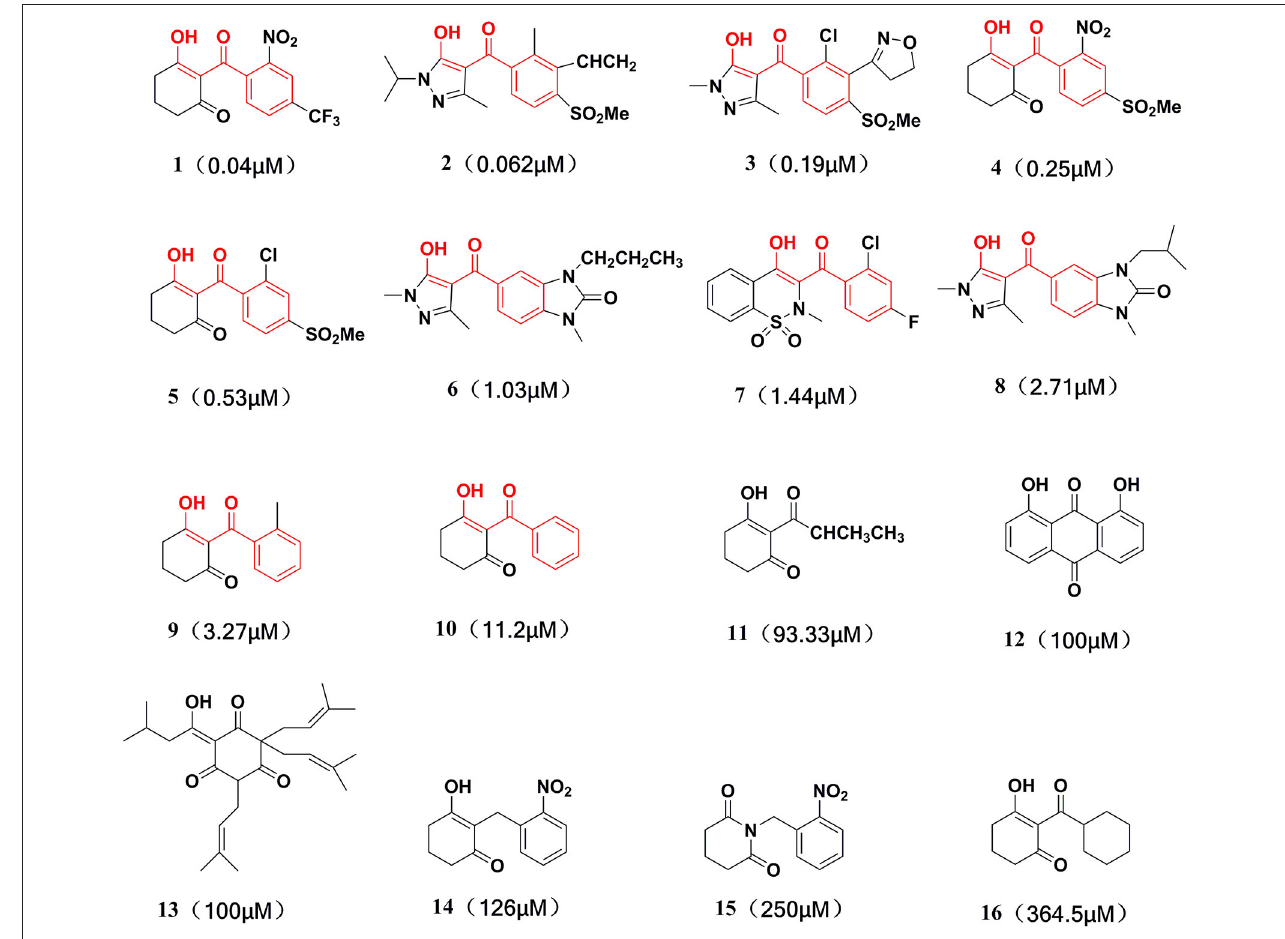
FIGURE 2 | Training set compounds with IC 50 values used for pharmacophore model